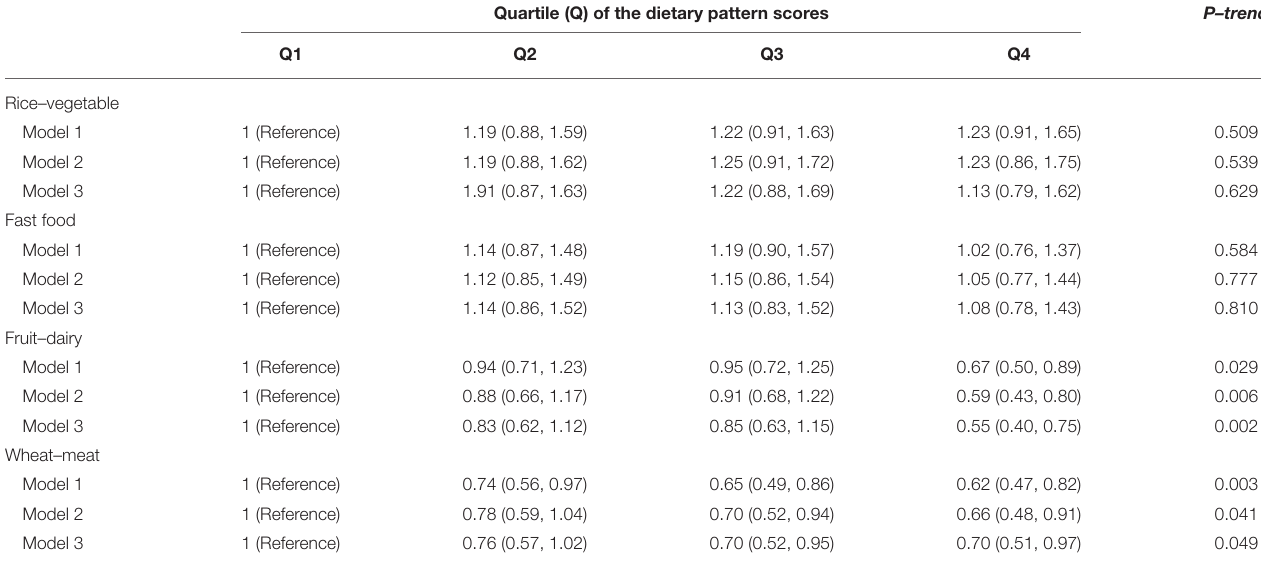
TABLE 4 | Adjusted odds ratio (95% CI) for the association between dietary patterns and hypertension ( n = 2,718). Quartile (Q) of the dietary pattern scores Q1 Q2 Q3